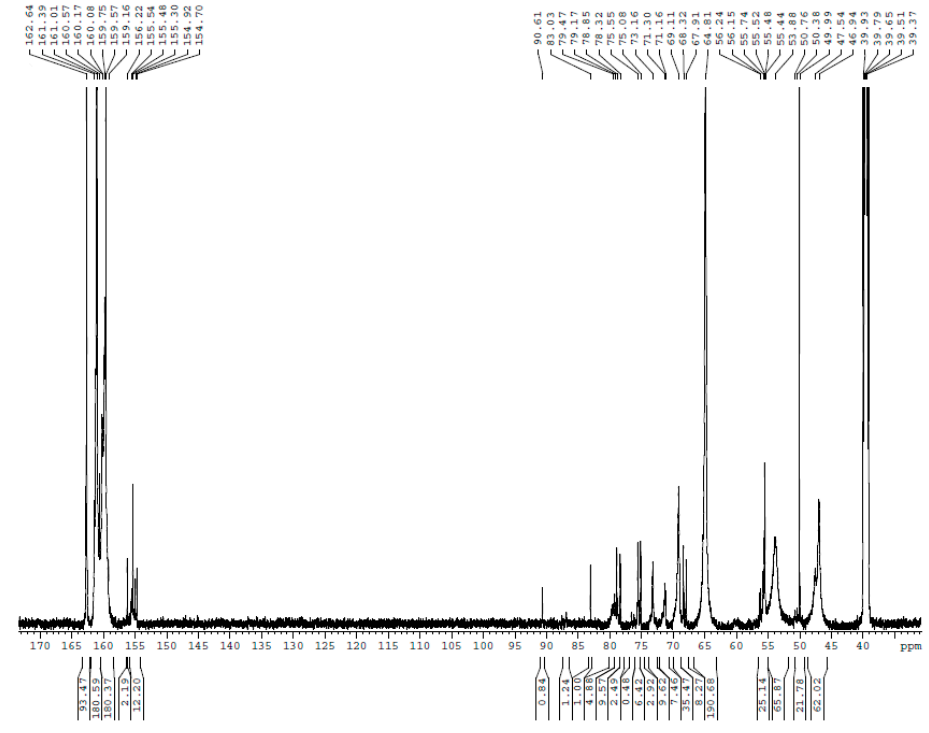
Figure 5. The 13 C NMR spectrum of sample UF-5. Table 1. Relative content of the methylenic and carbonyl carbons (%).